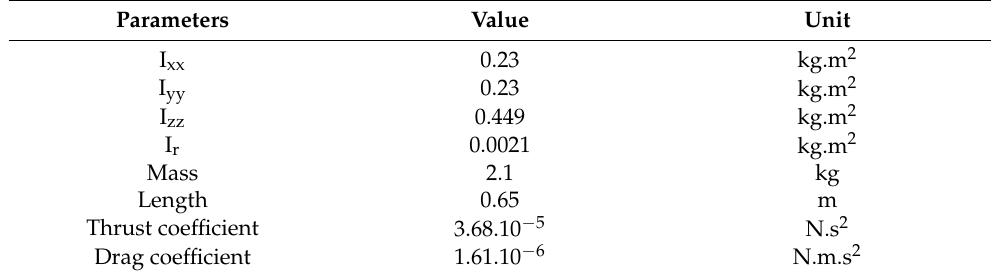
Table 2. System parameters.